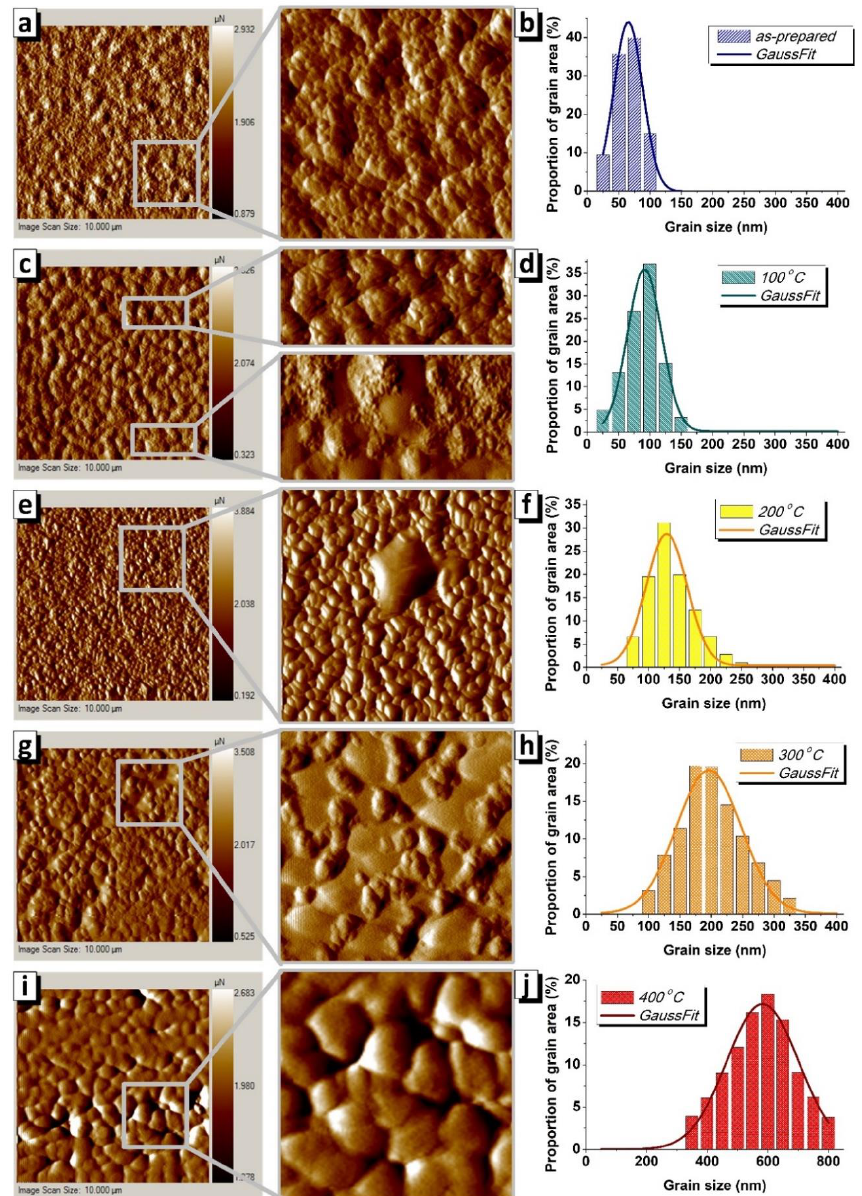
e ff ect on the surface layer and the internal volume of the material. Analysis of graphs in Figure 3a,b allows for us to conclude that the hardness and Young’s modulus of the as-prepared sample on the surface and in the bulk are quite close H 10nm = 8.64 ± 0.43 GPa, H 50nm = 7.51 ± 0.32 GPa and E 10nm = 183.6 ± 7.0 GPa, E = 196.8 ± 5.4 GPa. An increase in heat treatment temperature leads to a 50nm ◦ nonlinear increase in Young’s modulus to 256.1 ± 8.3 GPa (for 400 C) and hardness to 11.1 ± 0.98 GPa on the surface (black squares) and a simultaneous decrease in these parameters in the film volume (red circles), E 50nm = 165.1 ± 9.3 GPa, and H 50nm = 5.88 ± 0.58 GPa. The relatively high measurement error (in some cases more than 10%) is due to a significant di ff erence in the mechanical response of the material when the indenter hits the boundary or center of the grain.